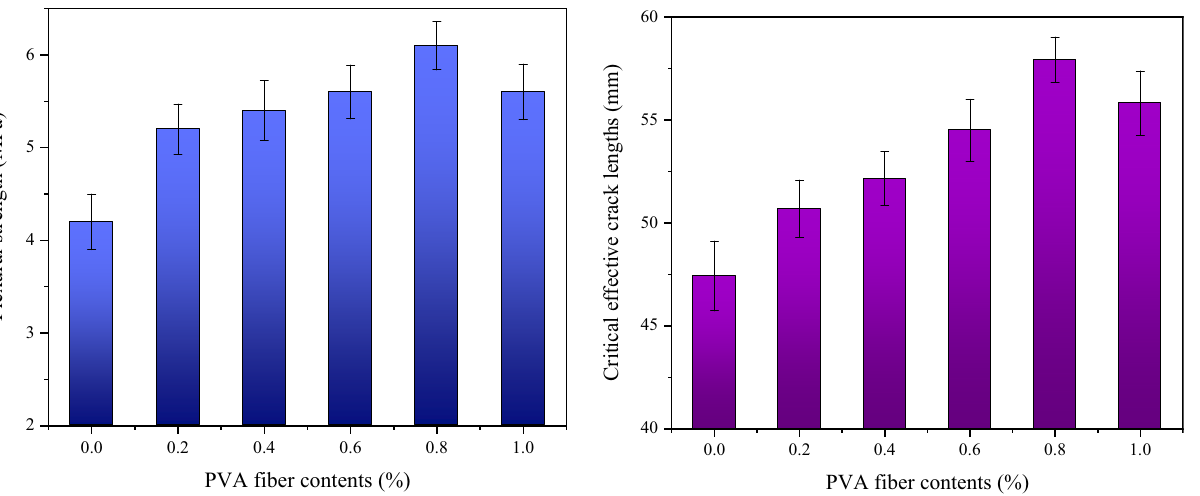
Figure 17: Flexural strength versus PVA fi ber contents.